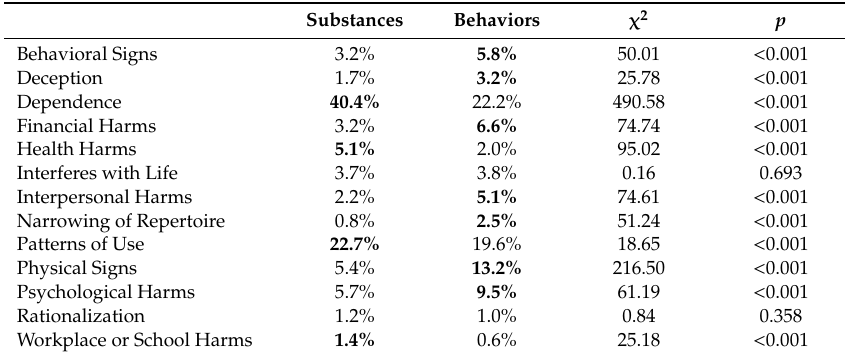
Table 4. Percentage of responses and di ff erences in theeq perceived most important indicators collapsed across substance and behavioral